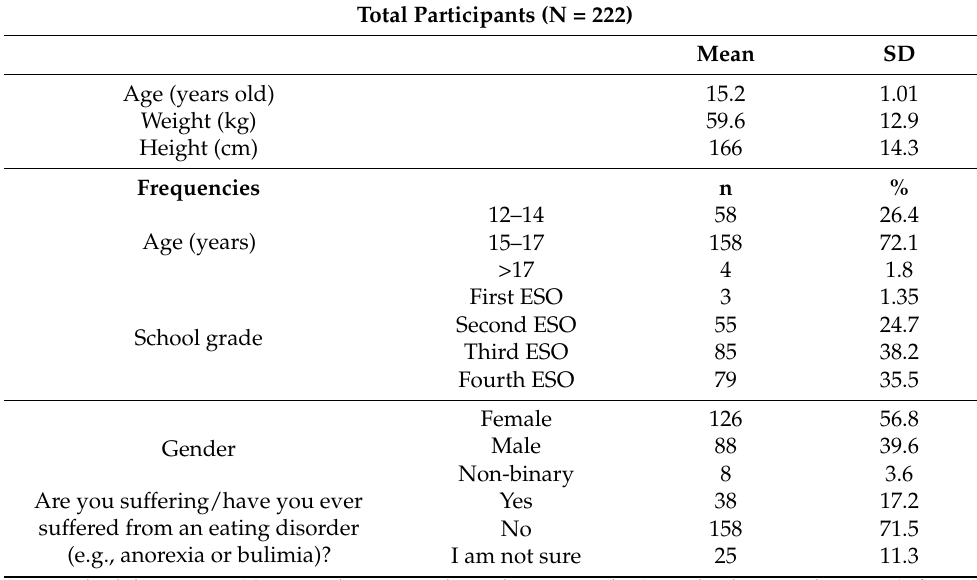
Table 1. Characteristics of the participants.